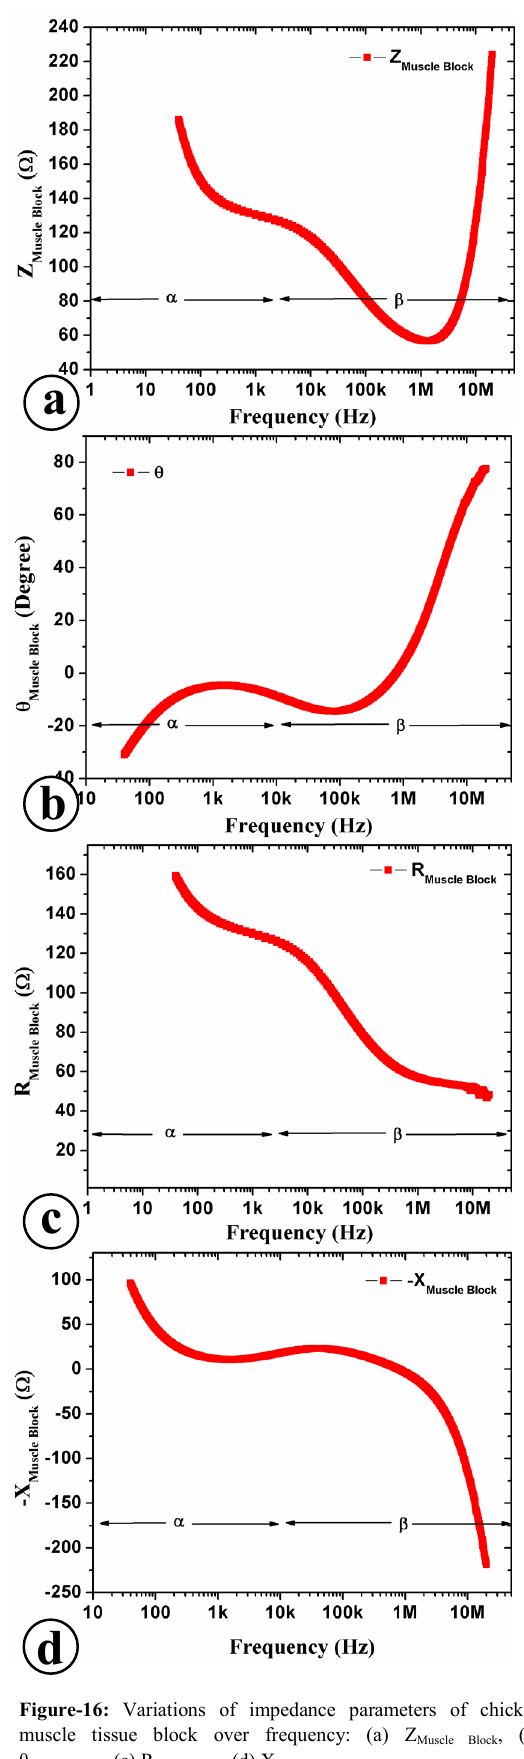
Figure-16: Variations of impedance parameters of chicken muscle tissue block over frequency: (a) Z Muscle Block , (b) θ Muscle Block , (c) R Muscle Block , (d) X Muscle Block